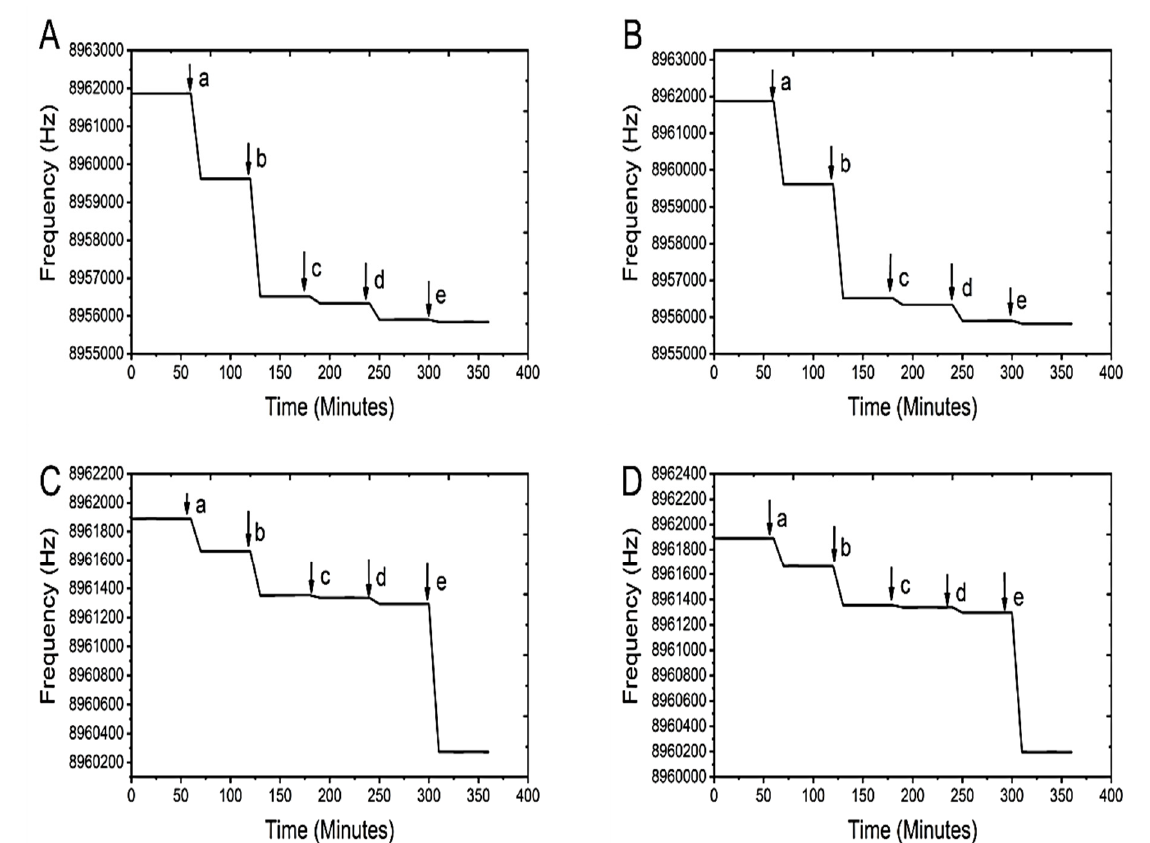
Figure 5. Stepwise modifications of the crystal using 4-TNM. Each plot represents the experiment with an E. coli concentration of ( A ) 1 × 10 3 CFU/mL, ( B ) 1 × 10 4 CFU/mL, ( C ) 1 × 10 5 CFU/mL, and ( D ) 1 × 10 6 CFU/mL. For each graph, (a) represents the addition of the linker molecule MUA, (b) represents the activation of the carboxyl group by EDC/NHS, (c) is the addition of the ligand, (d) represents the addition of glycine, and (e) is the detection of the E. coli .